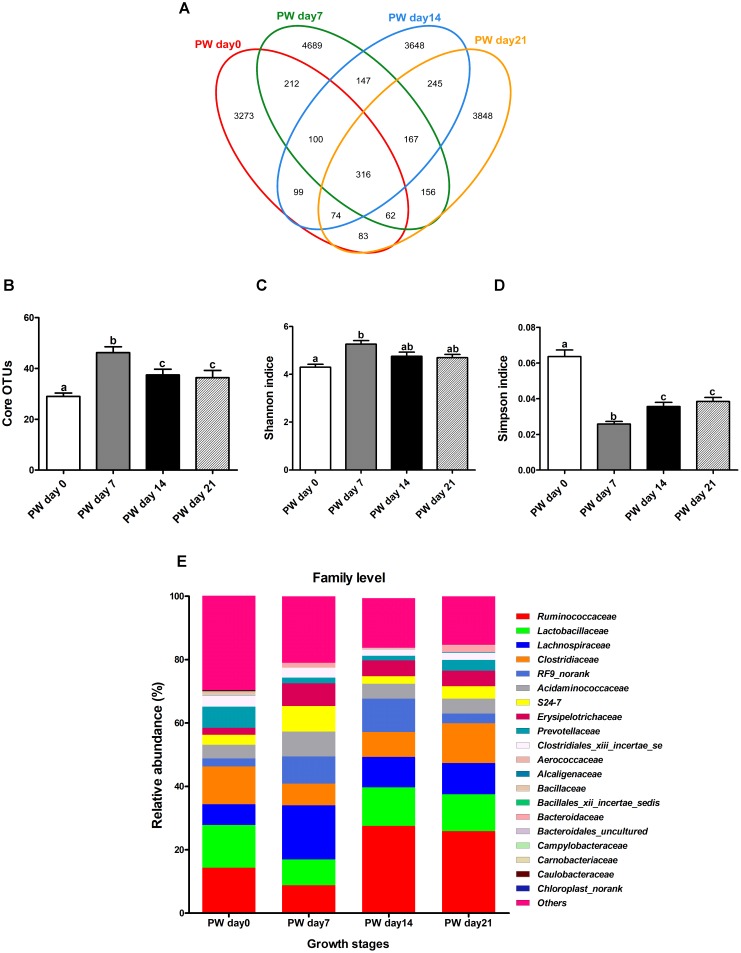
Jejunal microbial diversities and bacterial compositions of weaned piglets. Venn diagram showing the unique and shared operational taxonomic units (OTUs) (3% distance level) (A), core OTUs (>1.00% of the community) (B), estimated Shannon index (C), estimated Simpson index (D), and bacterial compositions at the family level (E) of jejunal samples from weaned piglets. OTUs, operational taxonomic units; PW, post-weaning. Bars (mean ± SEM, n = 5) with different letters are considered significantly different (P < 0.05).